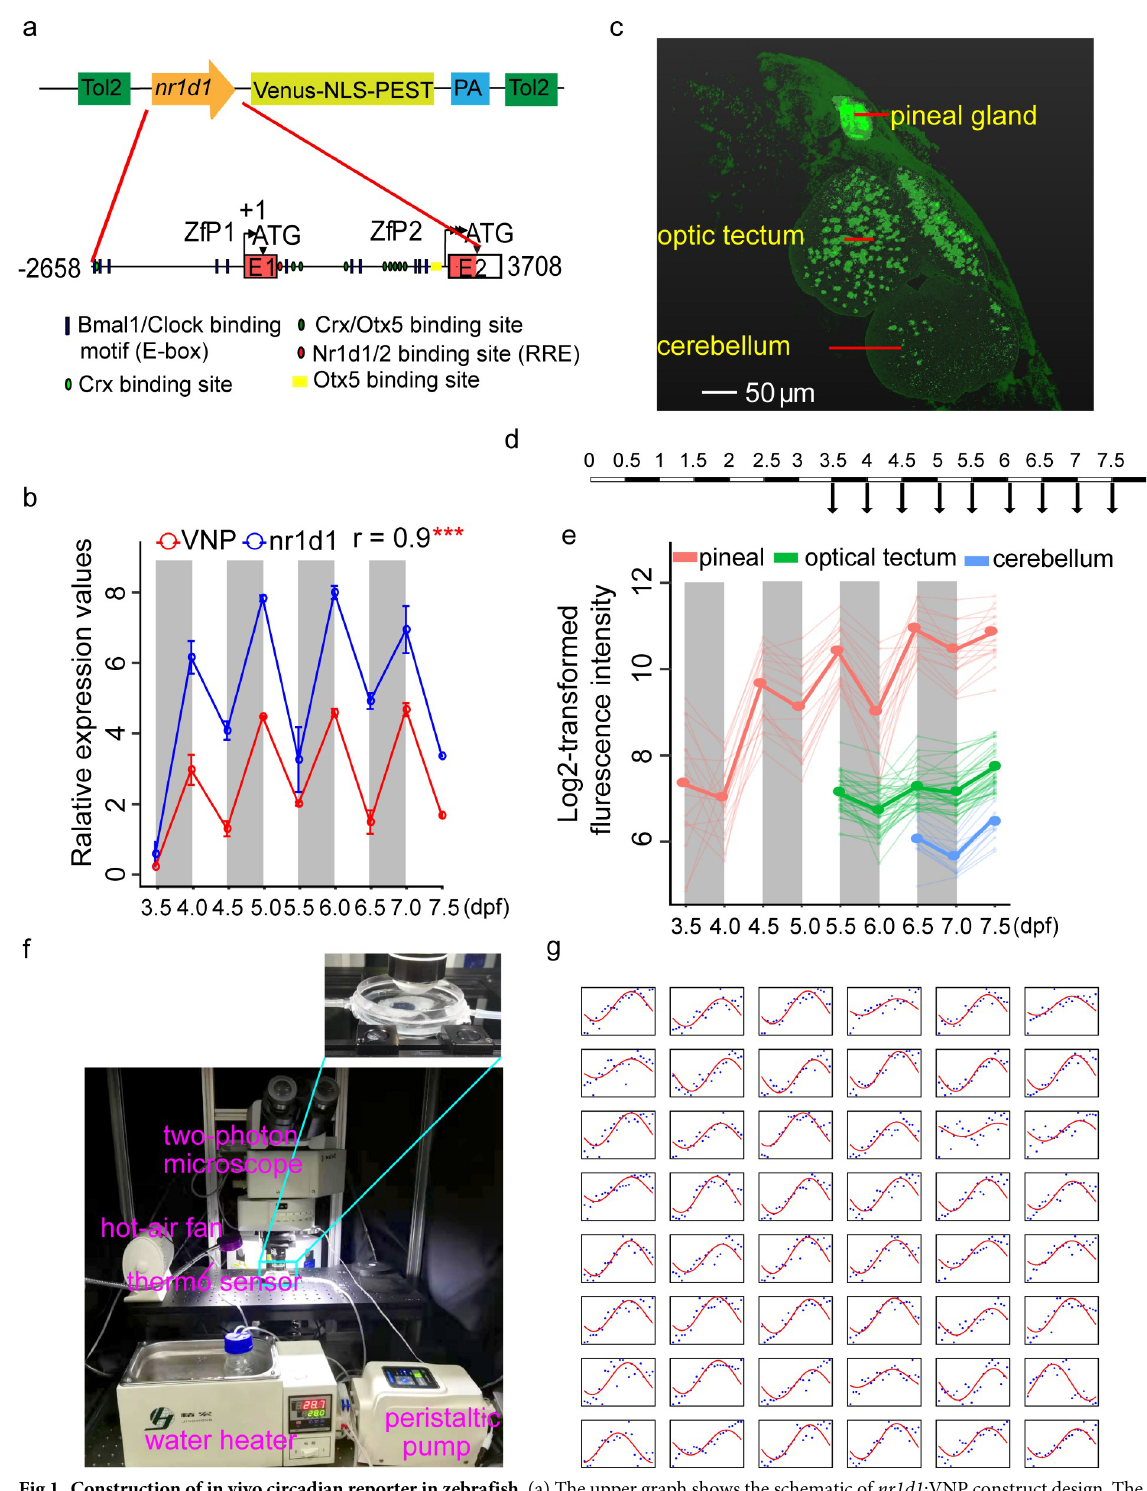
Fig 1. Construction of in vivo circadian reporter in zebrafish. (a) The upper graph shows the schematic of nr1d1 :VNP construct design. The lower graph shows a magnified view of the nr1d1 promoter sequence used for driving the circadian expression of VNP. The putative RRE (Nr1d1/2 binding site), E-box (Bmal1/Clock binding site), Crx, Otx5, and Crx/Otx5 binding sites were indicated by red oval, blue rectangle, light green oval, yellow rectangle, and dark green oval, respectively. (b) Plot of real-time PCR results of nr1d1 and Venus - pest expression. Each time point has 2 replicates, and each replicate is the pool of 7–10 fish. The dots show the original value, while the solid lines and the bars